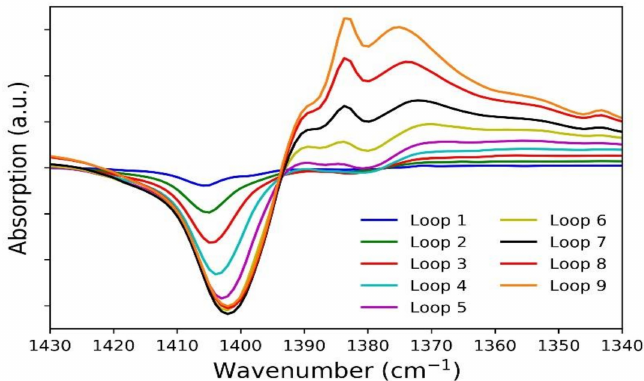
Figure 3. Di ff erence spectra for adsorption n -butane on sulfated zirconia (SZ) at T = 308 K. (“Loop 1” corresponds to the di ff erence spectrum between Loop 1 and the spectrum before adsorption and so